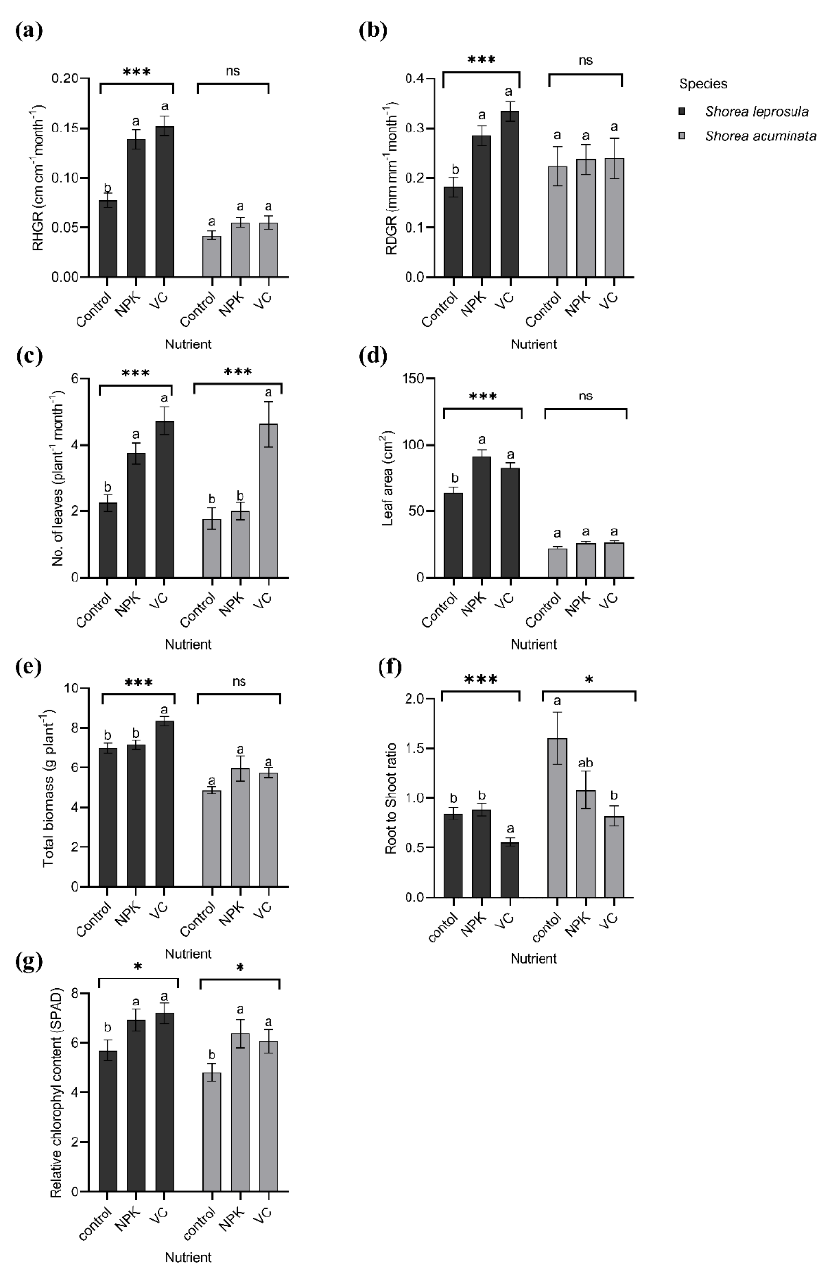
Figure 6. The growth performance of Shorea leprosula Miq. and Shorea acuminata Dyer to different nutrient amendments; ( a ) relative height growth rate (RHGR) (cm cm − 1 month − 1 ); ( b ) relative diameter growth rate (RDGR) (mm mm − 1 month − 1 ); ( c ) mean number of leaves (plant − 1 month − 1 ); ( d ) leaf area (cm 2 ); ( e ) biomass (g plant − 1 ); ( f ) root-to-shoot ratio; and ( g ) relative chlorophyll concentration (SPAD) (Mean ± SE). Alphabets denote significant differences between light irradiance treatments with *, and *** indicating significant at p < 0.05, and p < 0.001, respectively; ns = non-significant. The growth responses of S. acuminata only showed mean number of leaves as the highest value (approximately twofold) in VC compared to the control (Figure 6c). The RHGR, RDGR, and leaf area for both NPK and VC shared the same value and were 27%, 9%, and 17% higher than the control, respectively (Figure 6a,b,d). The RCC and total biomass were higher in NPK with 35% and 20%, respectively, compared to the control (Figure 6e,g). The root-to-shoot ratio was twice as low in VC than the control (Figure